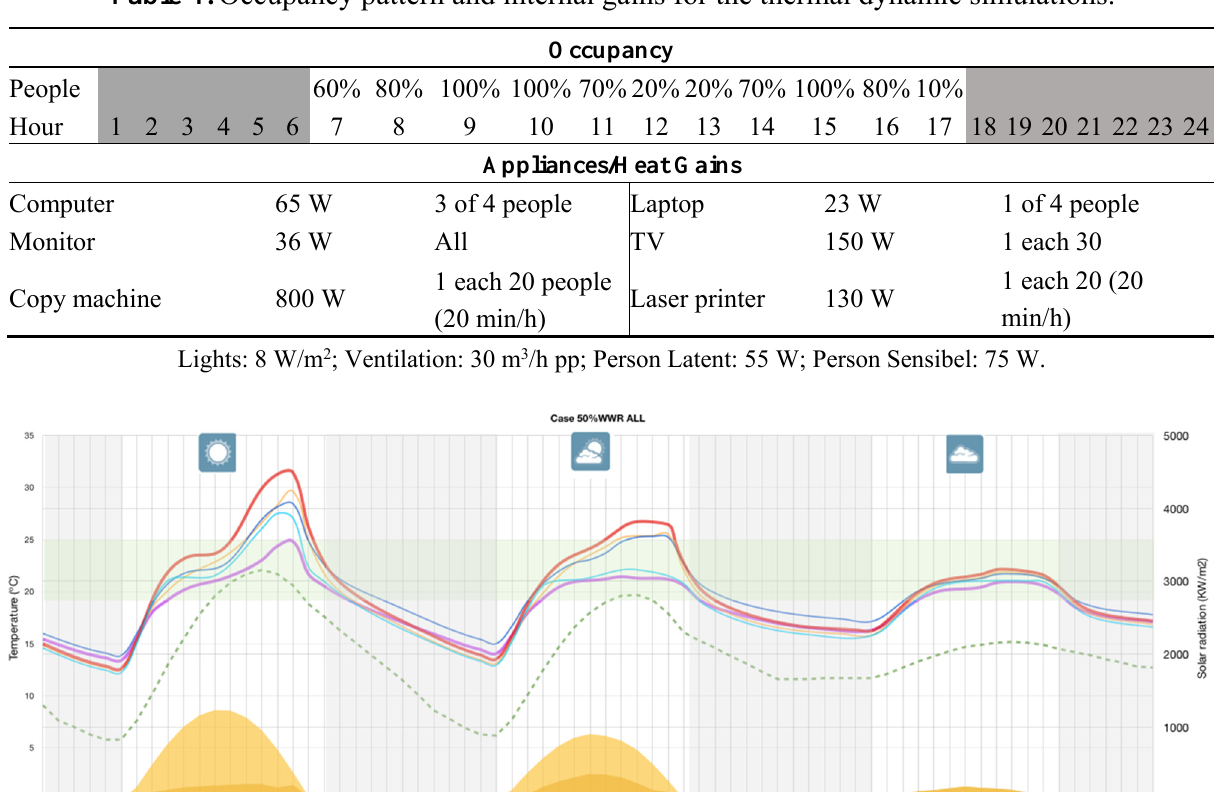
Figure 15. Design scenarios for the thermal dynamic simulations. Table 4. Occupancy pattern and internal gains for the thermal dynamic simulations.